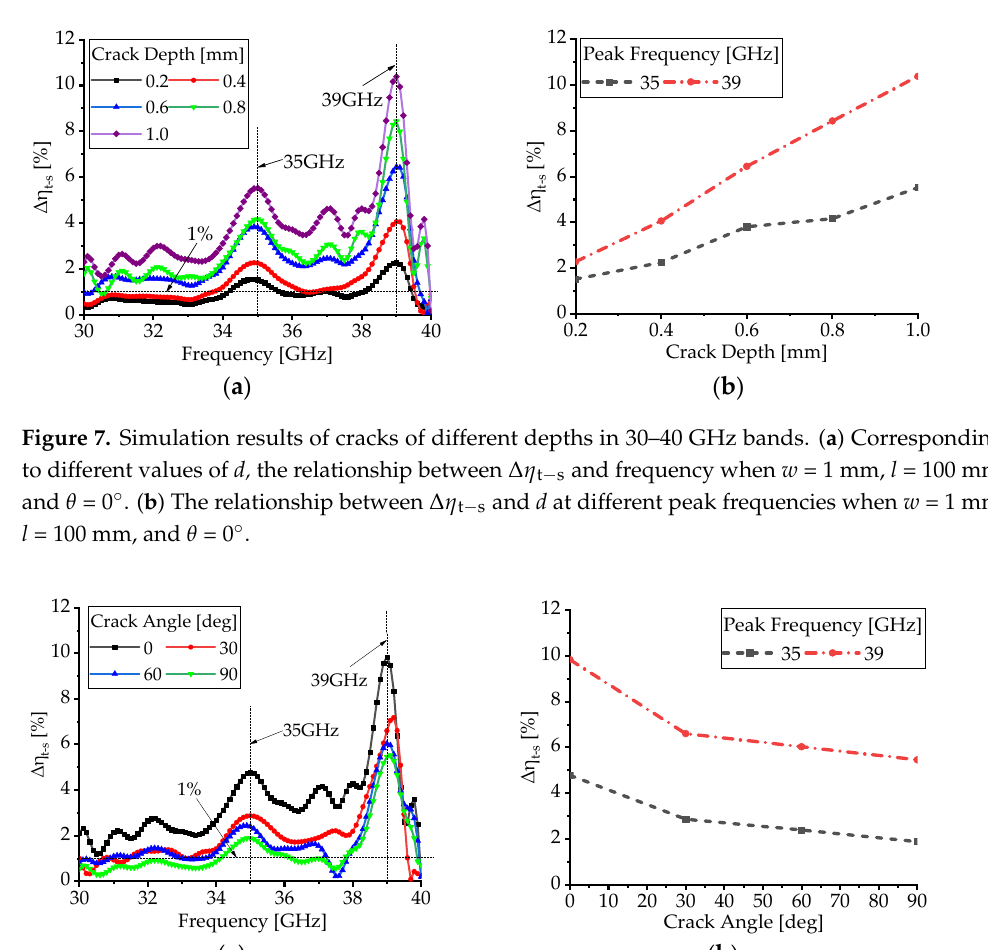
Figure 8. Simulation results for cracks of different angles in 30–40 GHz bands. ( a ) Corresponding to different values of θ , the relationship between ∆ η t − s and frequency when w = 1, d = 1, and l = 100 mm. ( b ) The relationship between ∆ η t − s and θ at different peak frequencies when w = 1, d = 1, and l = 100 mm.